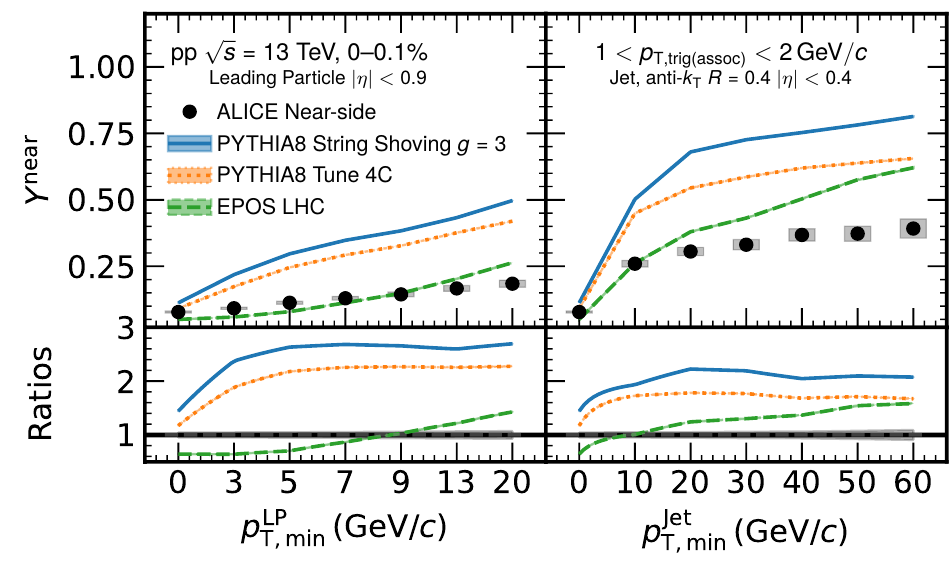
Figure 7 . Near-side jet-like peak yield as a function of the p LP filled circles show measurement with ALICE. The statistical and systematic uncertainties are shown as vertical bars and boxes, respectively. The measurements are compared with model descriptions from PYTHIA 8 Tune 4C , PYTHIA 8 String Shoving , and EPOS LHC for both selections. The total uncertainty of the ratio is represented by the gray band centered around